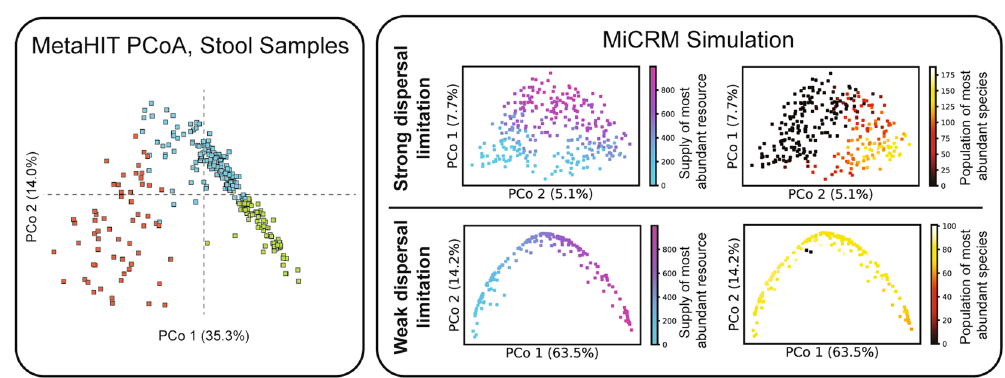
Figure 8. Pattern in ordination of compositions from single body site admits of multiple explanations. Left: Jensen-Shannon PCoA of MetaHIT stool samples, showing a characteristic ‘U’ shape that has been observed in many independent studies. Colors indicate three hypothesized enterotypes, which we do not discuss here. Reproduced with permission from Figure 3 of Ref. 30 . Right: Jensen-Shannon PCoA of simulated samples from Body Site 1 under two different levels of dispersal limitation. In the first (top), each community was initialized with 2,500 randomly chosen species out of the regional pool of 5,000. The communities display a continuous gradient in the population size of the most abundant species (over all samples) along the ‘u’ shape from one end to the other. In the second (bottom), each community started with 4,900 species. These communities display a continuous gradient of environmental conditions along the ‘U’ shape from one end to